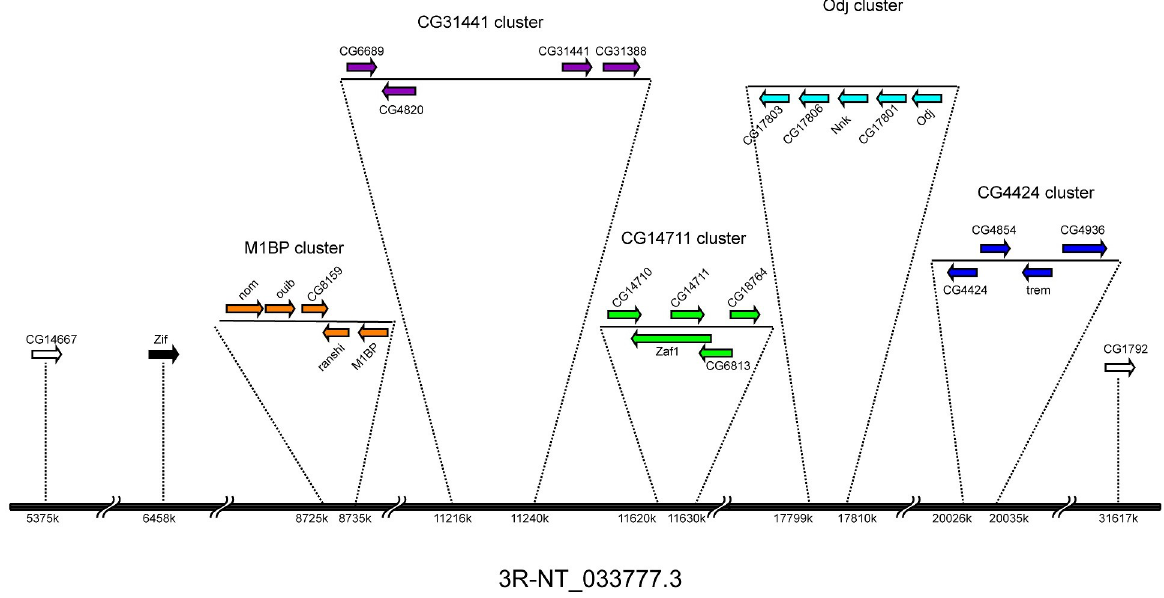
Fig 3. Synteny of genes in the Cucoid clade. Genes of the Cucoid clade are distributed in clusters on the right arm of chromosome 3, except CG9215 (not shown) which is located on the X chromosome. M1BP cluster (orange), CG14711 cluster (green), CG4424 cluster (blue), Odj cluster (light blue), CG31441 cluster (purple), Zif (black), other dispersed genes (outlined).